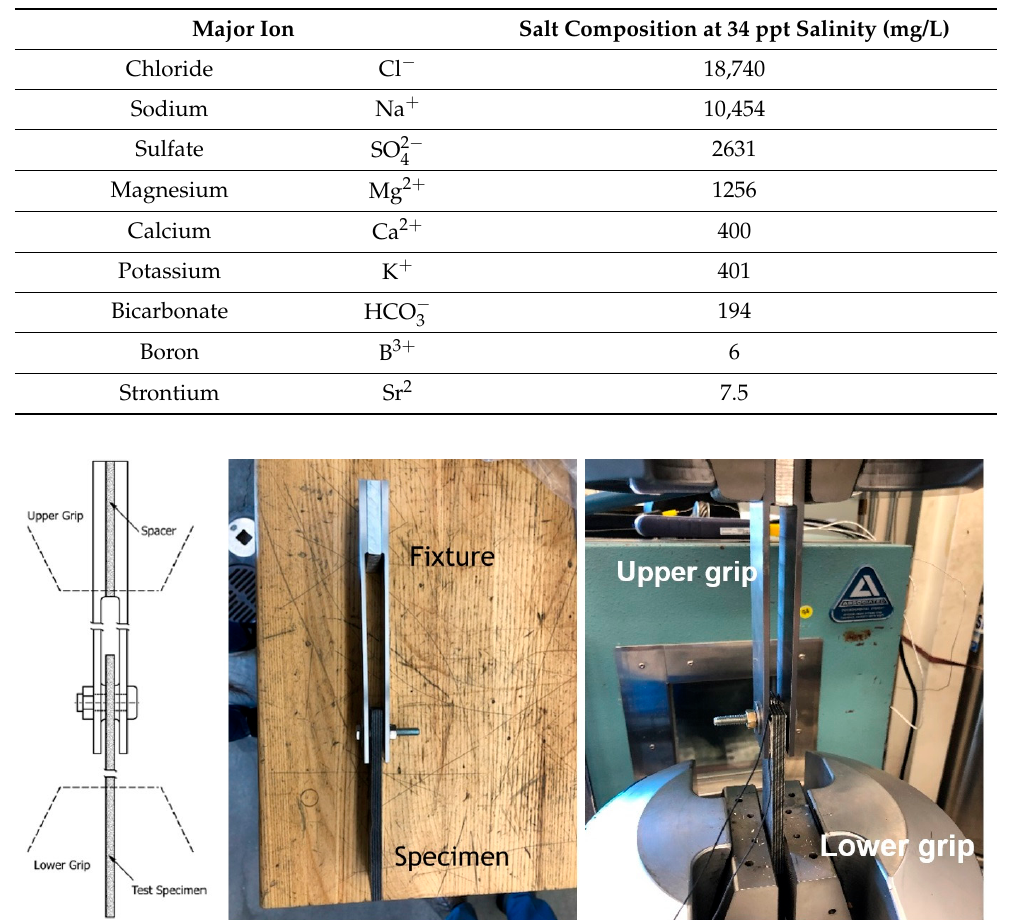
Figure 3. Example of the typical bearing test configuration used for analyzing mechanical proper- ties.